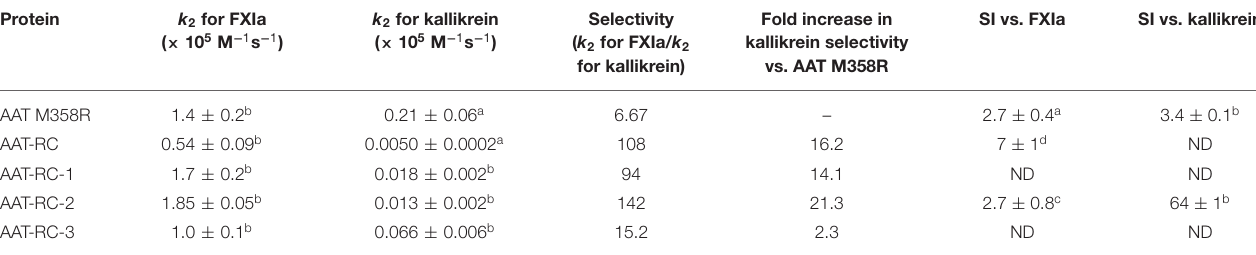
TABLE 2 | Kinetic parameter AAT variants compared to AAT M358R.